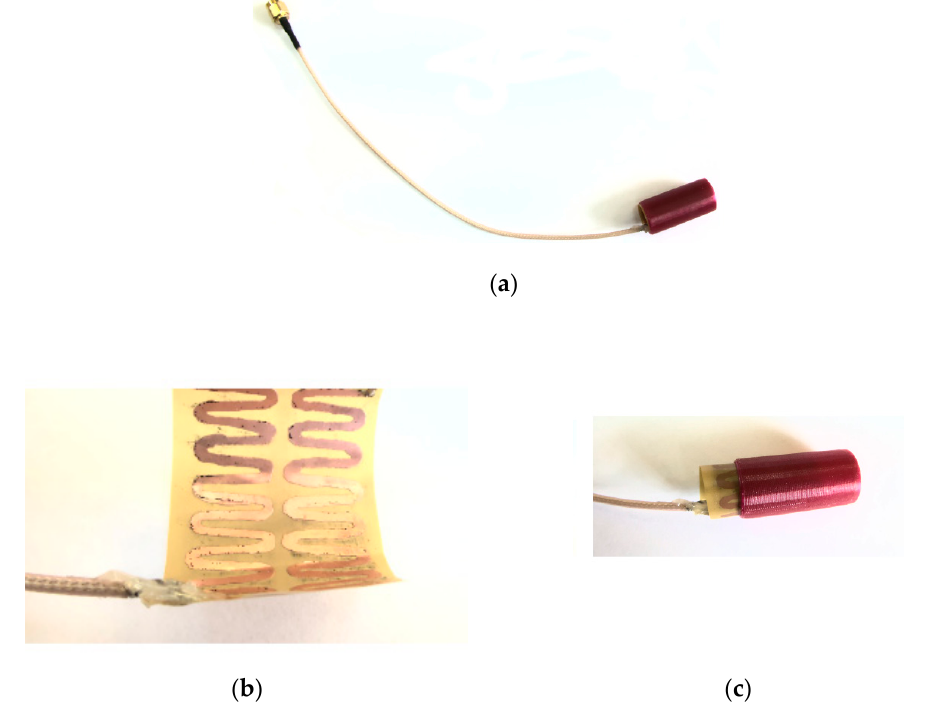
Figure 12. Prototype of proposed meander antenna: ( a ) antenna with coaxial cable, ( b ) antenna radiator fabricated on Pyralux substrate, ( c ) antenna radiator being inserted into 3D-printed cover.